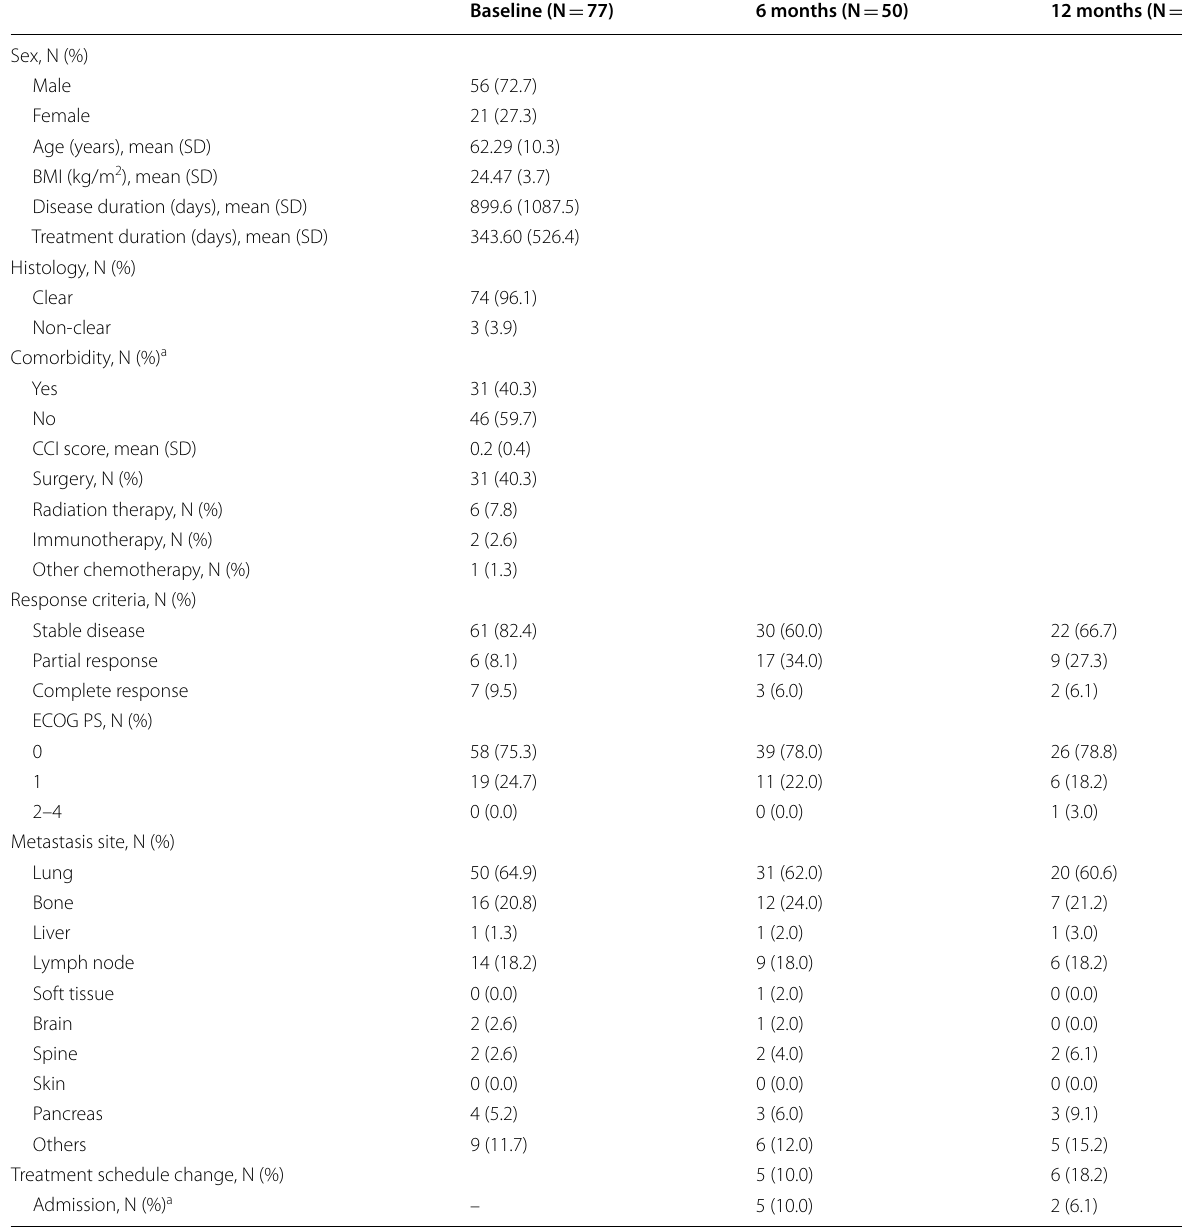
Table 2 Demographics and clinical characteristics of